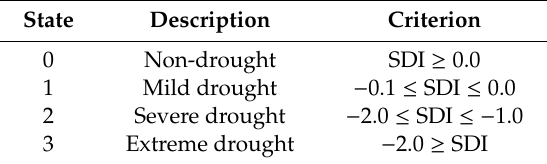
Table 2. Di ff erent states of hydrological drought based on SDI [60]. Table 2. Different states of hydrological drought based on SDI [60].